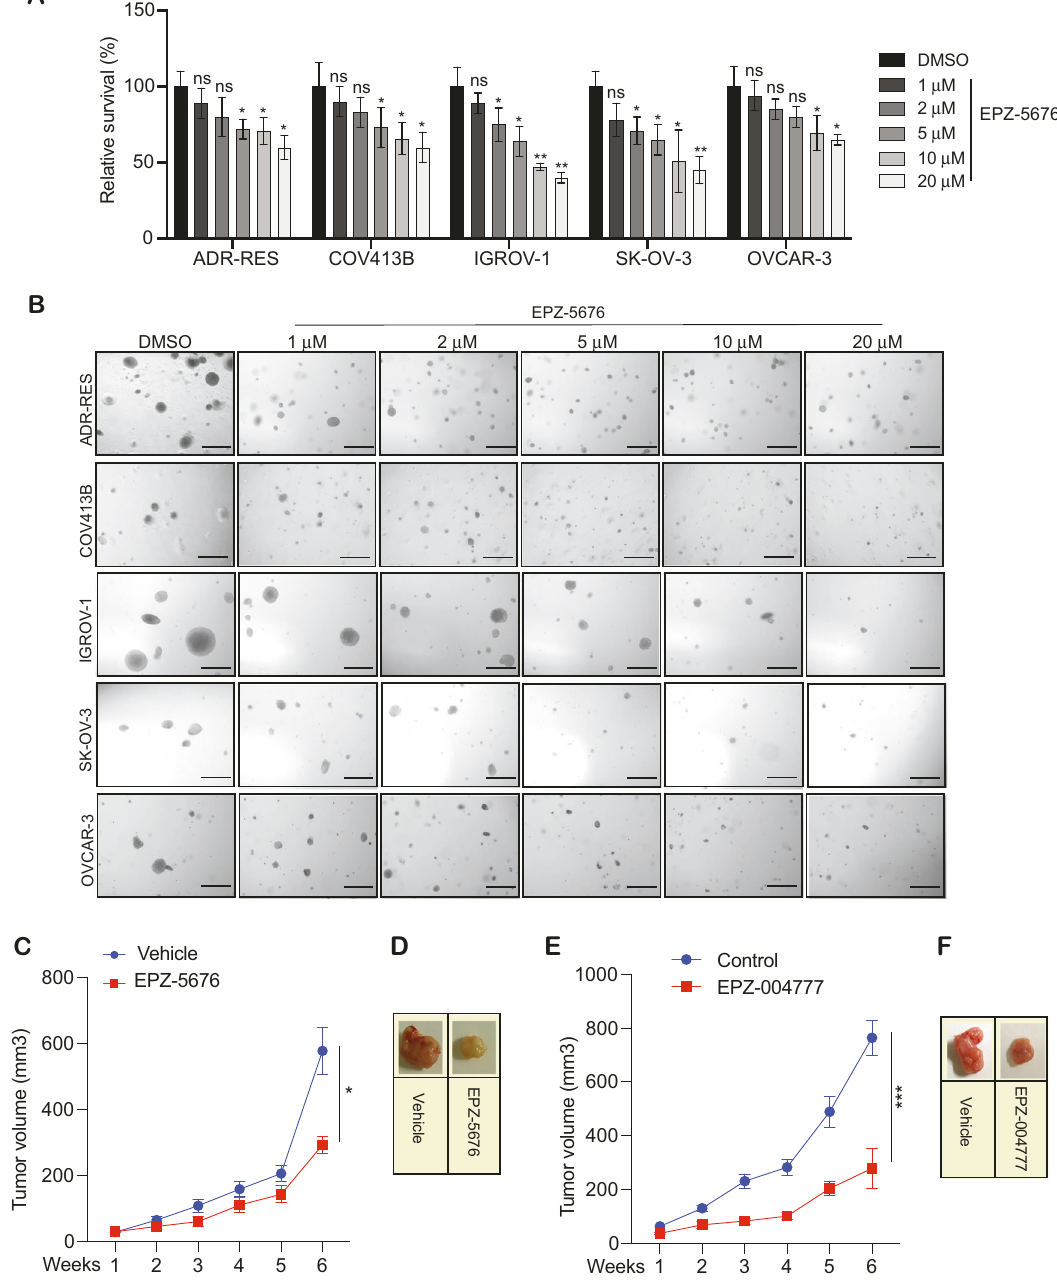
Fig. 3 Pharmacological inhibition of DOT1L inhibits the growth of ovarian cancer cells. A The indicated ovarian cancer cell lines were treated with the different concentrations of DOT1L inhibitor EPZ-5676 for 3 days and analyzed for cell survival in MTT assays. Relative cell survival is plotted with respect to control treated cells. B The indicated ovarian cancer cell lines were treated with various concentrations of EPZ-5676 and analyzed for the ability to grow in an anchorage-independent manner in soft agar assays. Representative images of soft agar assays are shown. Scale bar, 500 μ m . C , D IGROV-1 cells were injected subcutaneously into the fl anks of NSG mice ( n = 7). The mice were treated with EPZ-5676 (50 mg/kg) intraperitoneally every day and analyzed for tumor growth. Tumor sizes were measured each week and the average tumor volume is plotted ( C ). Representative images of the tumors from the mice after 6 weeks of EPZ-5676 treatment are shown ( D ). E , F IGROV-1 cells were injected subcutaneously into the fl anks of NSG mice ( n = 5). The mice were treated with EPZ004777 (50 mg/kg) intraperitoneally every day and analyzed for tumor growth. Tumor sizes were measured each week and the average tumor volume is plotted ( E ). Representative images of the tumors from the mice after 6 weeks of EPZ004777 treatment are shown ( F ). Data were shown as the mean ± SEM, * p < 0.05, ** p < 0.01, *** p < 0.001, ns not signi fi cant, calculated using the Student ’ s t EPZ-5676, both EPZ004777 and SGC0946 effectively inhibited selective DOT1L inhibitors with an IC50 of 0.4 and 0.3 nM, the H3K79 dimethyl (H3K79me2) mark and suppressed short- respectively in a cell-free assay. Both of these inhibitors term growth of the ovarian cancer cells in the MTT assay selectively inhibit cellular H3K79 methylation and suppresses (Supplementary Fig. 2). They also effectively inhibit the ability of the cancer cells proliferation [24 – 27]. We found that similar to